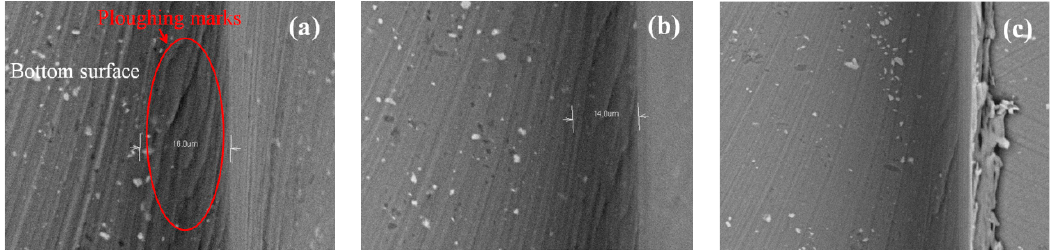
Figure 10. Surface topographies with a feed rate of ( a ) 0.8 µm/flute ( b ) 1.2 µm/flute ( c ) 1.6 µm/flute.